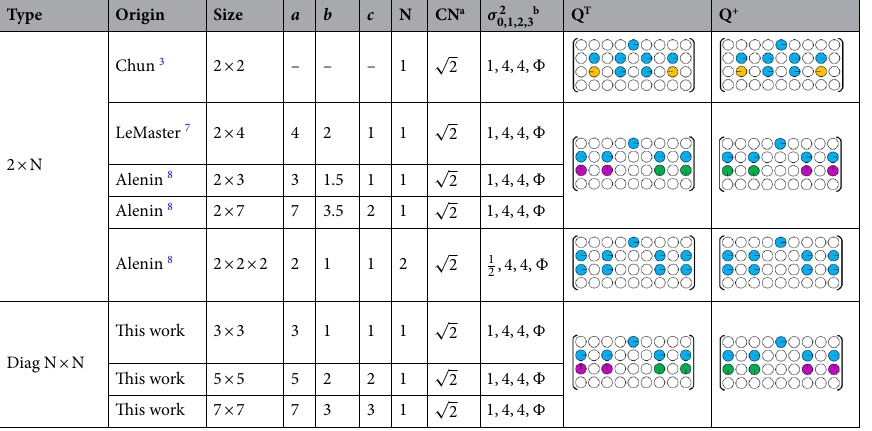
Table 1. Notable micropolarizer array patterns. The circles represent the coefficient’s polar form of the frequency phase matrix, and the total number of circles is 9 × 4 = 36. The direction of the radius line in the circles represents the phase information as: right = + 1, up = + j, left = − 1, down = − j. The frequency phase matrix in Eq. (7) indicates that there have nine channels, which contain four empty channels and five non- empty channels. Empty circles indicate that the locations of the channels do not contain the information of Stokes parameter 8 . a CN is the condition number, which ensures the optimal configuration for W 12 . b σ 2 0,1,2,3 are the noise variances from Q , which is a 9 × 4 matrix; the EWV is the sum of σ 2 0,1,2,3